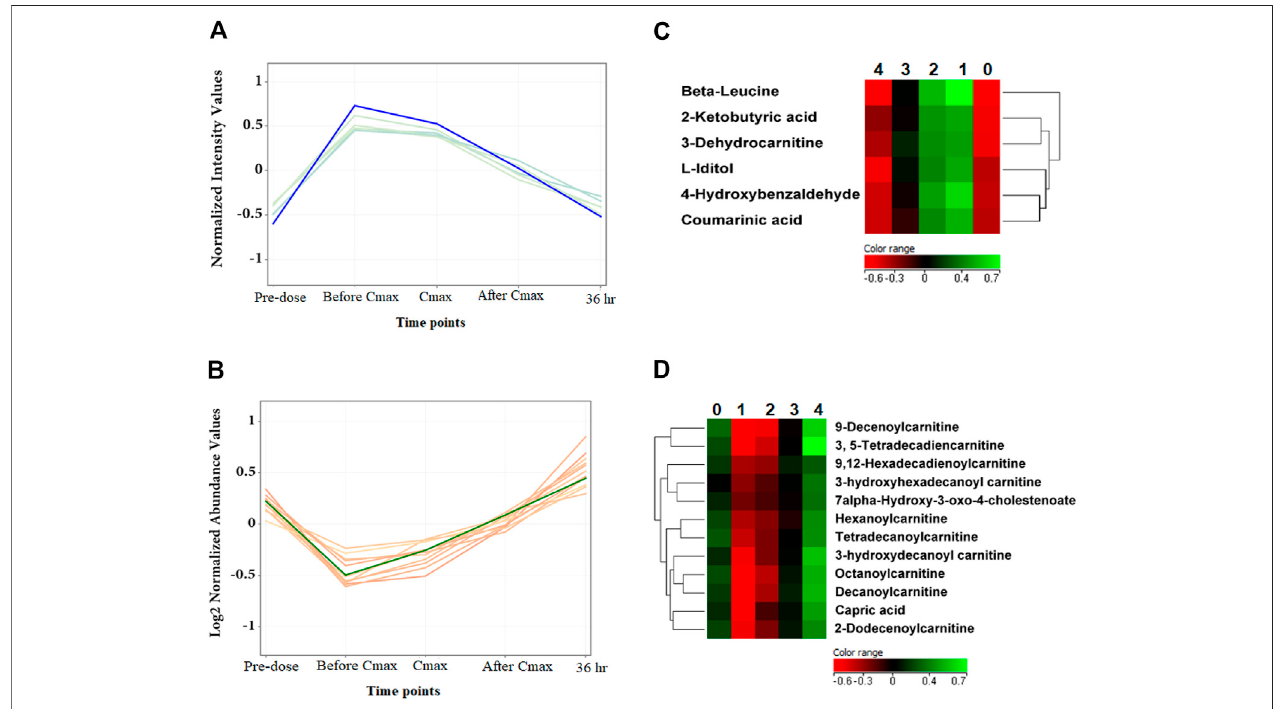
FIGURE 5 | The level of metformin-independent metabolites at the fi ve-time points. (A, B) The 6 and 12 metformin-independent metabolites, respectively, initially increasedordecreased,followedbyasubsequentlineardecreaseorincreaseintheirmetaboliclevels. (C,D) Hierarchalclustering(HAC)andheatmapanalysisofsigni fi cantly altered metformin independent metabolites. Time points 0, 1, 2, 3, and 4 refer to baseline, before C max , C max , after C max, and 36 h post metformin administration.